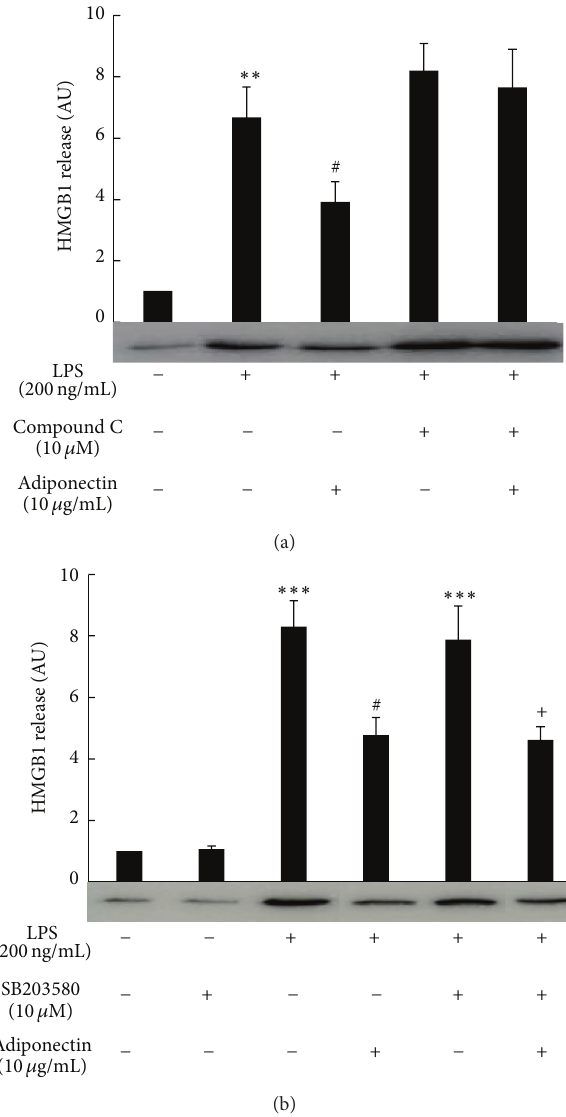
Figure 6: Effect of kinase inhibitors on the suppression by adiponectin of LPS-induced HMGB1 release. Raw 264 cells were cultured as described in Figure 1 legend and were treated with compound C (a) or SB203580 (b) for 1h before treatment with adiponectin (10 𝜇 g/mL) for 18h, following which they were stimu- lated with LPS (200ng/mL) for another 24 h. Culture media were collected and analyzed by HMGB1 western blotting followed by quantification of the intensity of the chemiluminescent HMGB1 band. The results are expressed as means ± SE of three independent experiments ( ∗∗∗ 𝑝 < 0.001 and ∗∗ 𝑝 < 0.01 significance compared withcontrol; # 𝑝 < 0.05 significancecomparedwithLPStreatedcells; + 𝑝 < 0.05 significance compared with LPS plus SB203580 treated